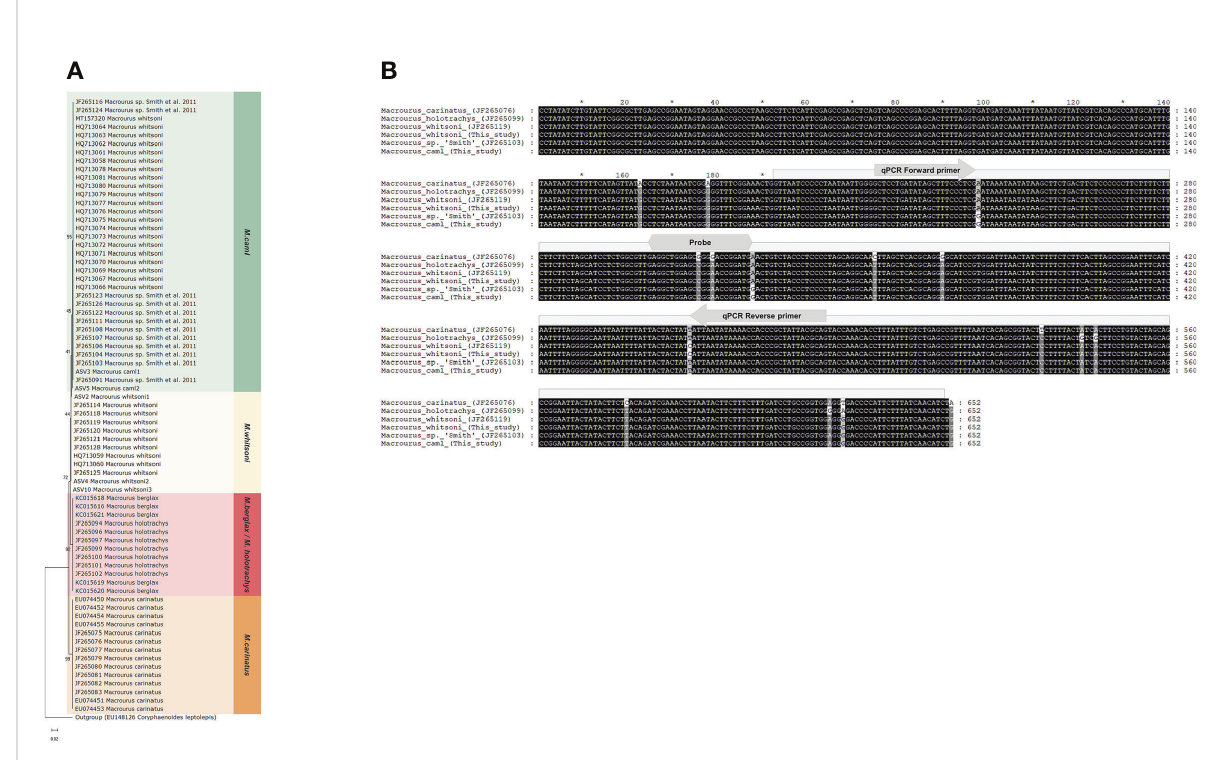
FIGURE 3 Genetic comparison of fi ve species in the genus Macrourus . (A) Phylogenetic tree of the genus Macrourus based on the cytochrome c oxidase subunit I (COI) barcode region used in this study. COI sequences of genus Macrourus were obtained from the GenBank database. Minimum evolution tree was constructed using Kimura 2-parameter model and 1000 bootstrap replication by MEGAX. The sequence information for the fi ve species of Macrourus is provided in Supplementary Data 2. (B) Multiple sequence alignment of the genus Macrourus COI generated using the universal COI primer set (Fish-BCL, Fish-BCH). The box with diagonal lines represents the metabarcoding regions used in this study. The arrow and hexagon indicate the quantitative polymerase chain reaction (qPCR) primer set and probe regions of Macrourus caml and Macrourus whitsoni . *A mark that separates 10 base